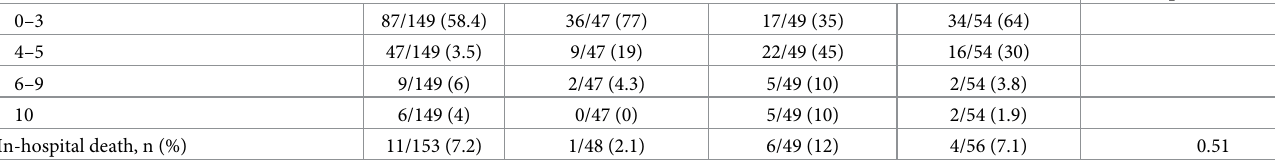
a patients who retrospectively fulfilled the prescriptive criteria for anakinra but did not receive the drug. b patients admitted for COVID-19 pneumonia but who presented with baseline suPAR < 6 ng/mL. c p-values from the comparison between anakinra group and CG1. d Ordinal regression analysis comparing anakinra group and CG1.